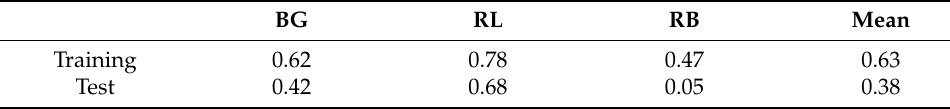
Table 16. IoU scores for Rice blast in Experiment C.